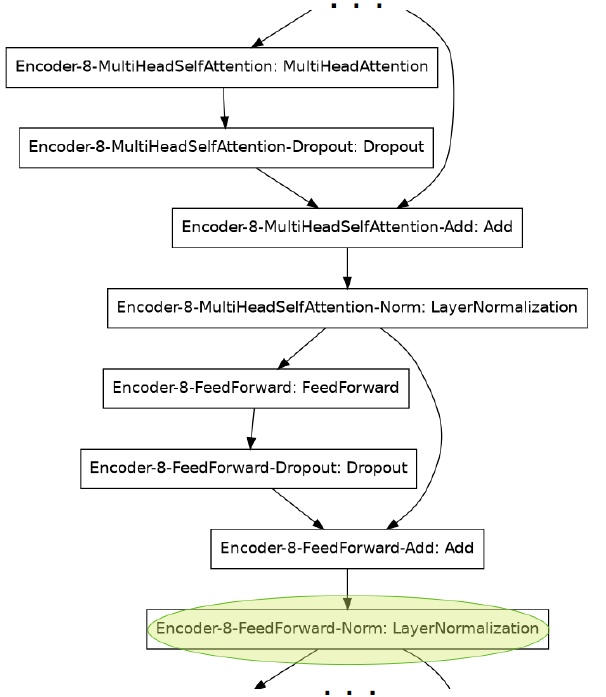
Figure 4. An encoder block of the CuBERT transformer. The activation spaces are defined on the highlighted feedforward layers.